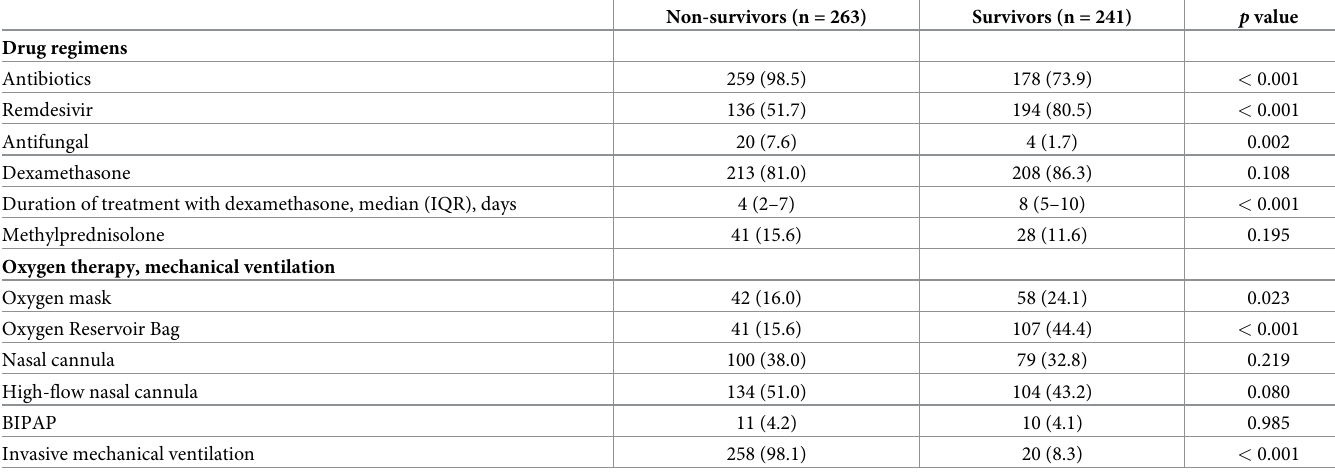
Table 4. Treatment for patients with